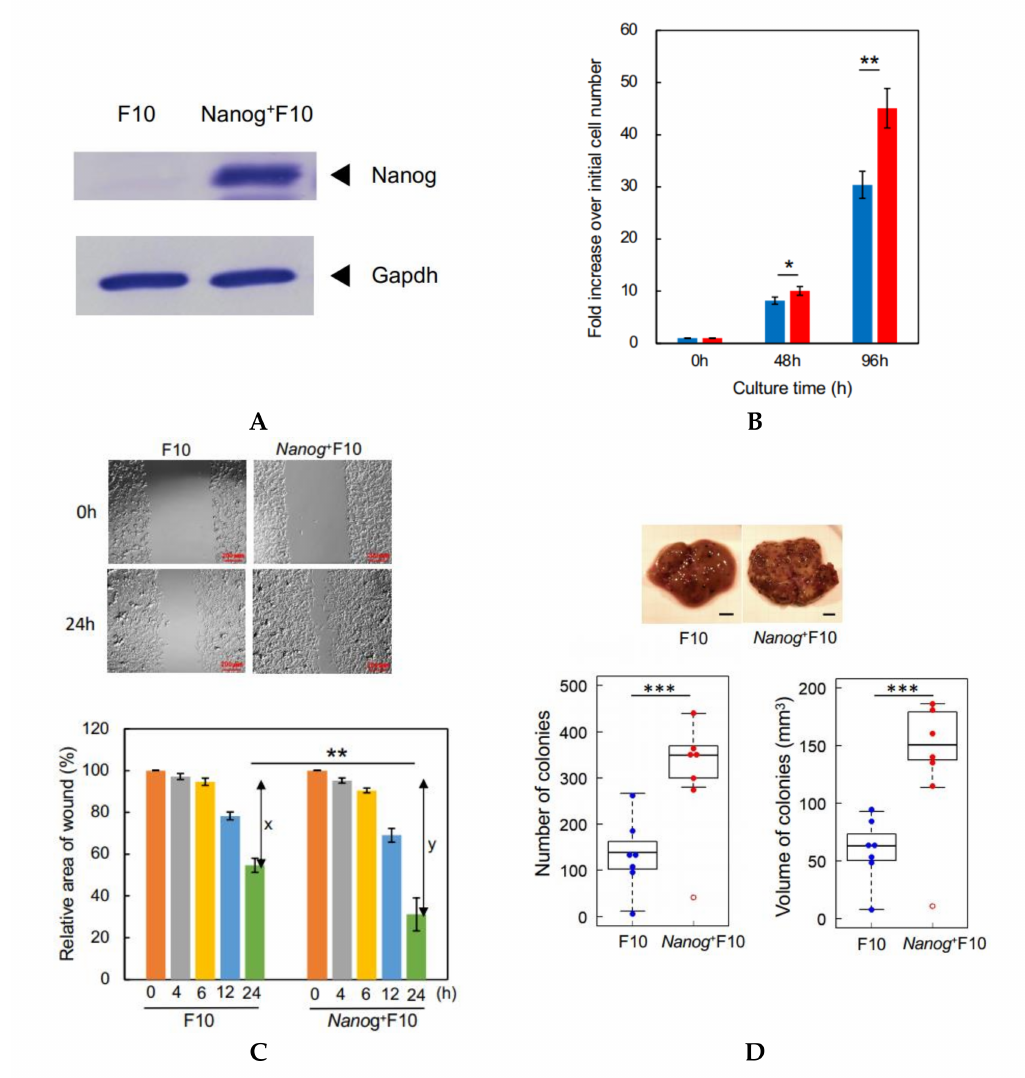
Figure 1. Properties of a Nanog + F10 cell line. ( A ) Confirmation of Nanog expression in Nanog + F10 cell. ( B ) Relative rate of cell proliferation in cultures of F10 and Nanog + F10 cells. mean ± SD, for n = 3. ( C ) Wound-healing assay to compare migratory activity of F10 and Nanog + F10 cells. The smaller the value in the graph, the higher the migratory activity. x and y indicate the healed areas measured at 24 h in respective cultures. Here, x and y were 42% and 69%, respectively. Therefore, y/x was 1.64. Bars are mean ± SD, for n = 4. ( D ) Representative images, number, and volume of metastasis colonies in the liver of mice. Scale bar, 5 mm; n = 7 excluding outliers ( ◦ ). The image of ( A ) was cropped from red dotted lines on full-length gel images shown in Supplementary Figure S1. ***: p < 0.001, **: p < 0.01, *: p <